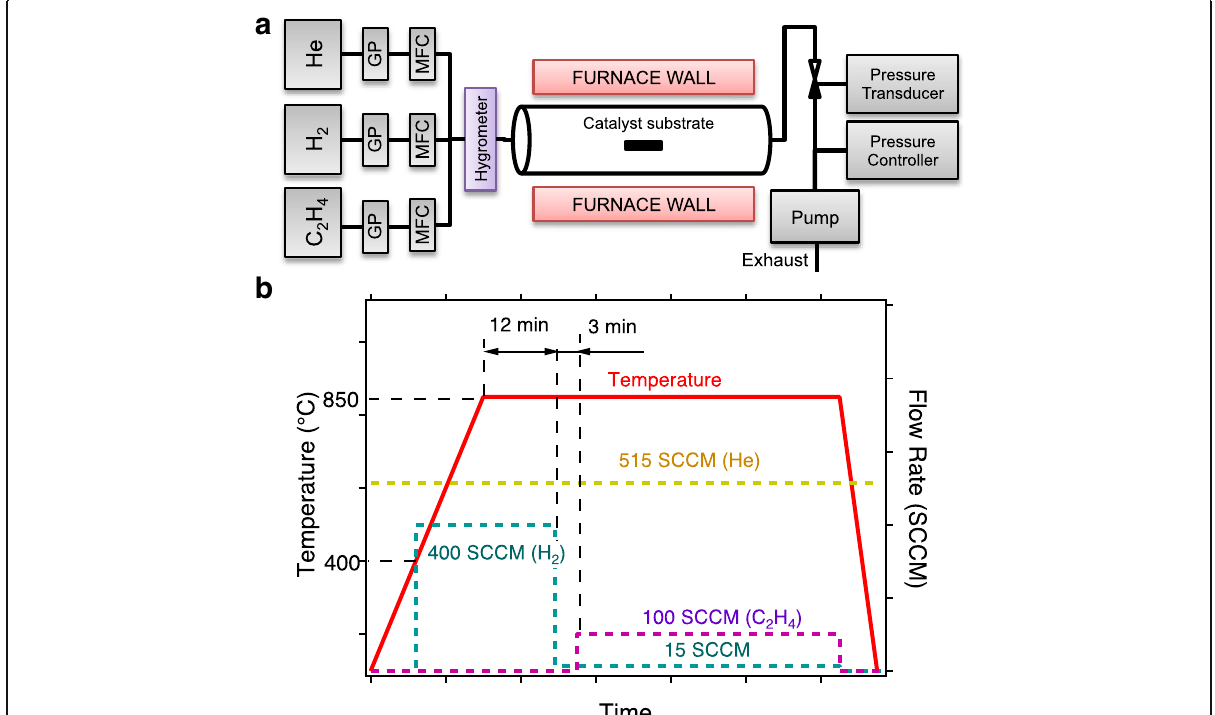
Fig. 1 a Schematic of the CVD system (GP gas purifier, MFC mass flow controller). b CVD process diagram describing the change in furnace temperature and gas combination with respect to process